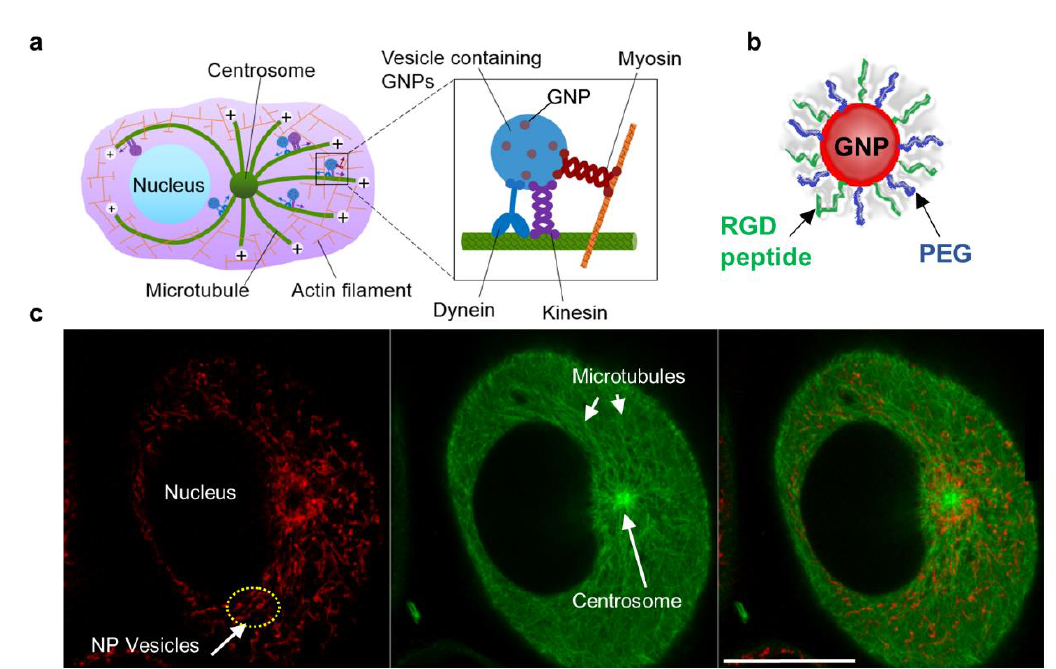
Figure 1. Intracellular transport of NPs. ( a ) Schematic diagram showing the transport of vesicles containing NPs within the cellular microtubule network. MTs are long tubulin polymers and are often anchored at the centrosome. Their plus ends extend toward the cell periphery, whereas their minus ends are located closer to the cell centre and are often anchored at the centrosome. Inset figure: Vesicular transport along MTs is supported by the motor proteins, dynein and kinesin. NP transport along actin filaments is supported by motor proteins closer to the cell periphery. ( b ) Representation of a single GNP functionalized with PEG and RGD peptides. ( c ) Snapshot of a live cell showing vesicles containing NPs (marked in red; left most), MTs (marked in green; middle), and the merged image (right most). Scale bar is 20 µm.